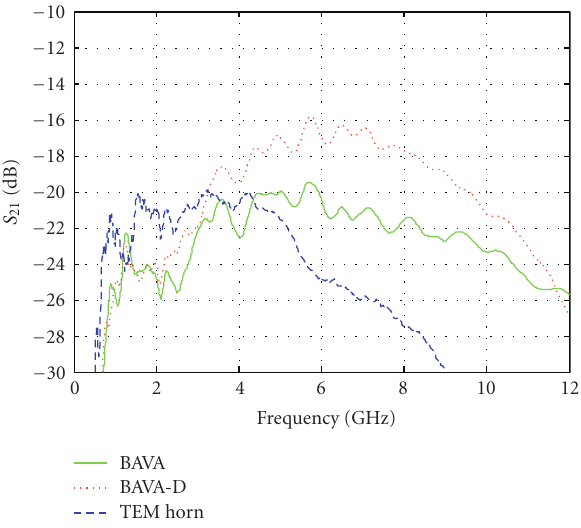
Figure 9: Measured S 21 for all 3 antennas. Table 1: Antenna performance 2cm from aperture. The maximum fidelity value is